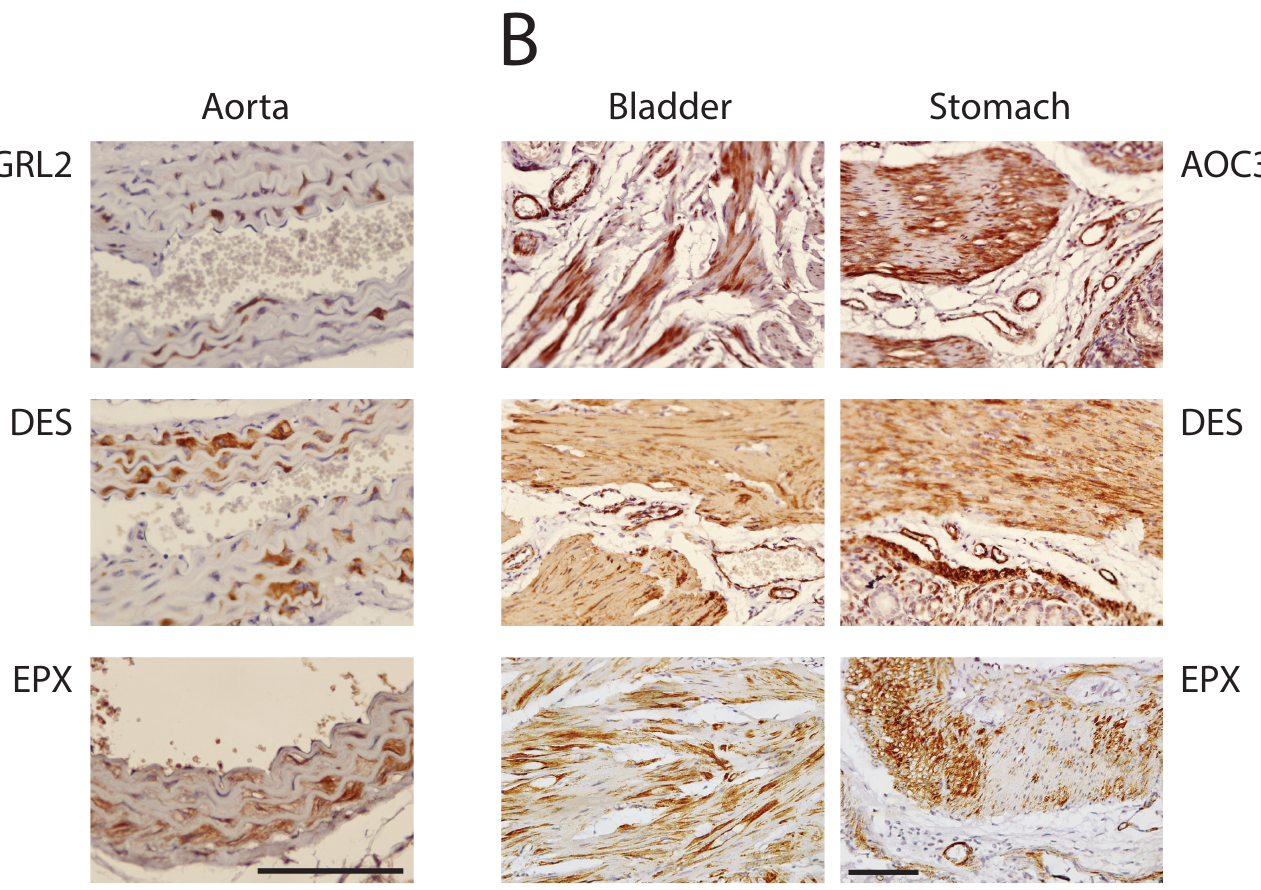
Fig 4. Smooth muscle cell heterogeneity in mouse. Several antibodies to smooth muscle proteins demonstrated heterogeneity of expression in VSMC that was clearly seen in the aorta (A) and in non-vascular SMC in bladder and stomach (B) of mouse.